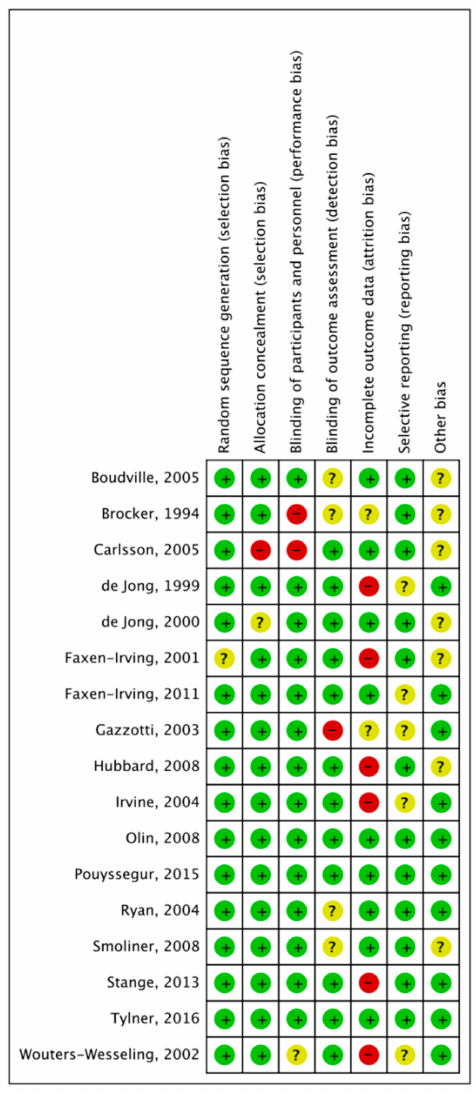
Figure 3. Risk of bias summary: judgements about each risk of bias item for each included